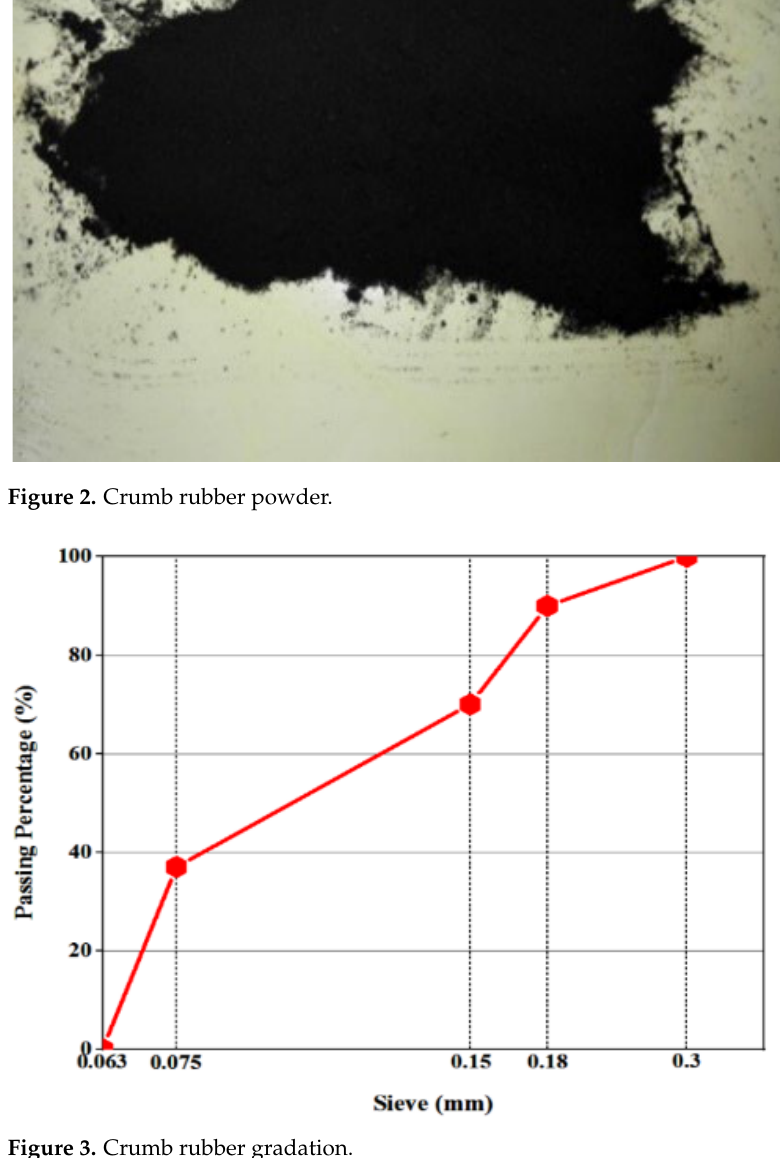
Figure 3. Crumb rubber gradation.